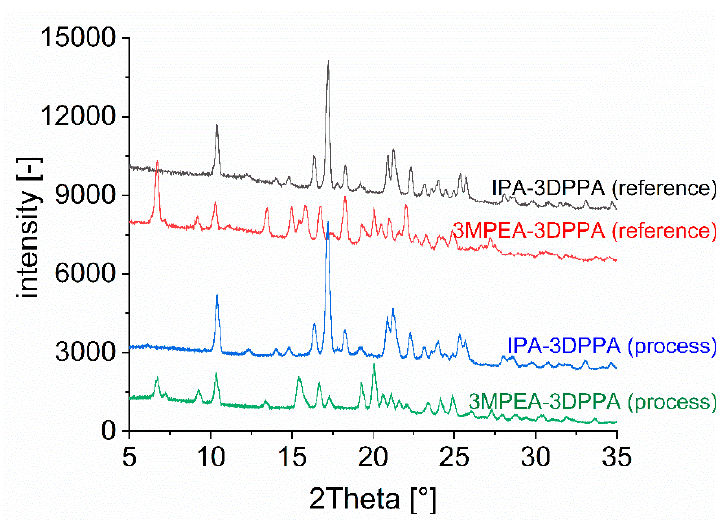
Figure 7. Crystal morphology of donor salt (left) and product salt (right).